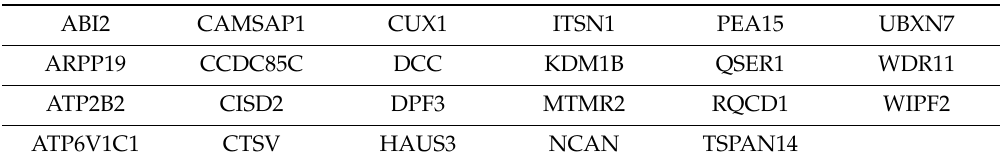
Table 2. Common targets of hsa-miR-494 (upregulated) and hsa-miR-9 (downregulated) in RB tumor and RB